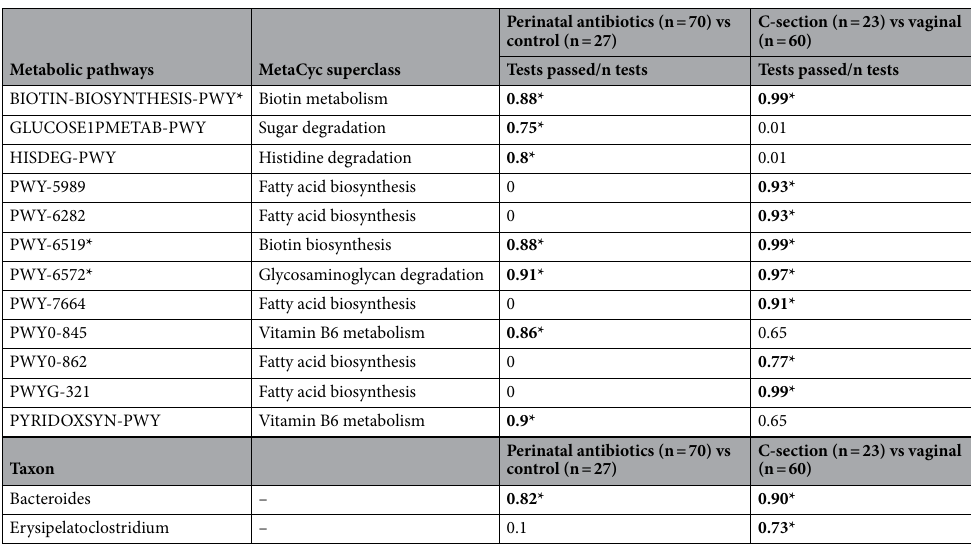
Table 1. Differential abundance analysis of metabolic pathways in the gut microbiomes of two cohorts using ANCOM2 analysis. ANCOM2 outputs a proportion of pairwise statistical tests passed for each feature (tests passed/n tests). For this value, exceeding the threshold of 0.7 was considered significant (bold). *Proportion > 0.7 for both delivery mode (vaginal delivery vs C-section) and perinatal antibiotic exposure (any vs none) are statistically